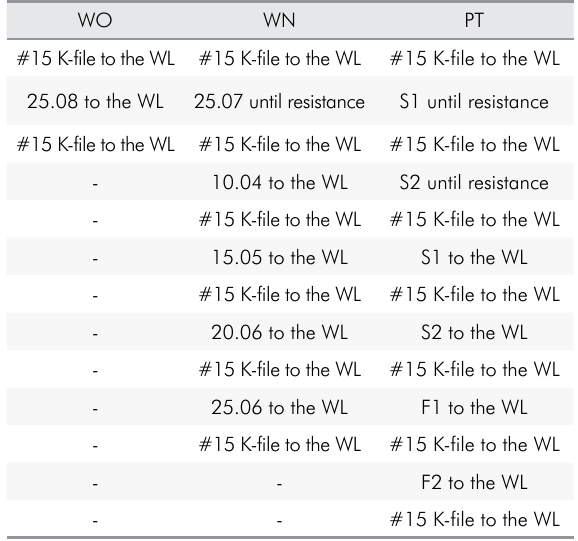
Table 1. Sequence of instruments used for preparation of the root canals in each group: Wizard Navigator (WN), WaveOne (WO), and ProTaper Universal